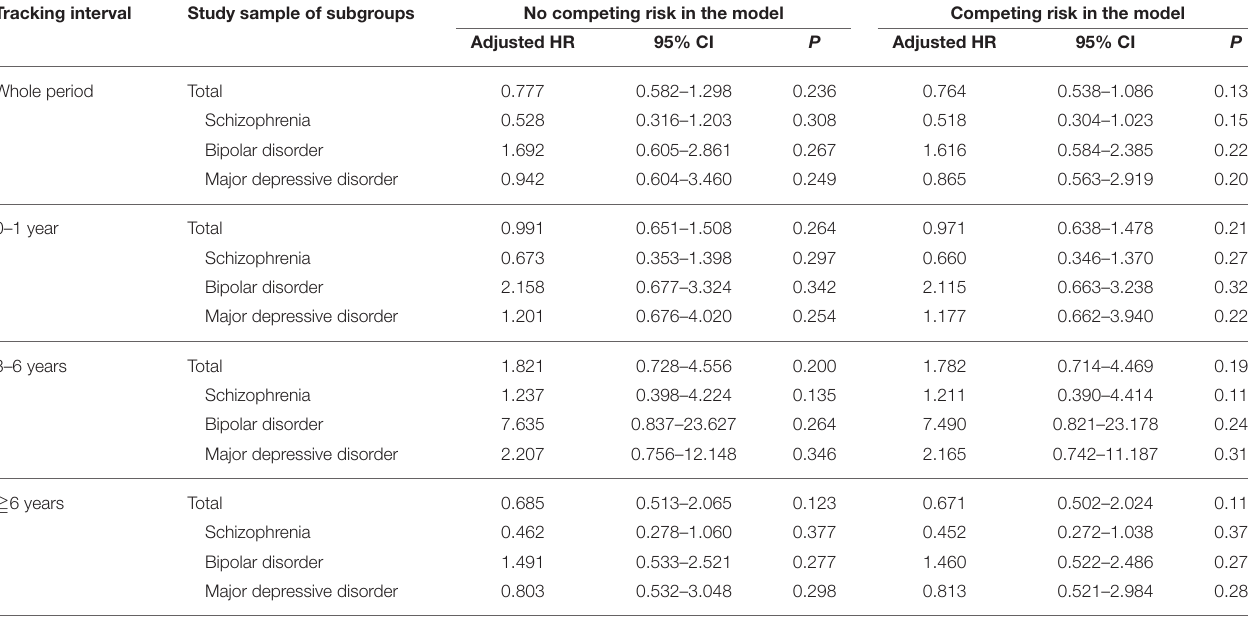
TABLE 5 | Sensitivity analysis for the risk of dementia after ECT in Fine and Gray’s survival analysis model. Tracking